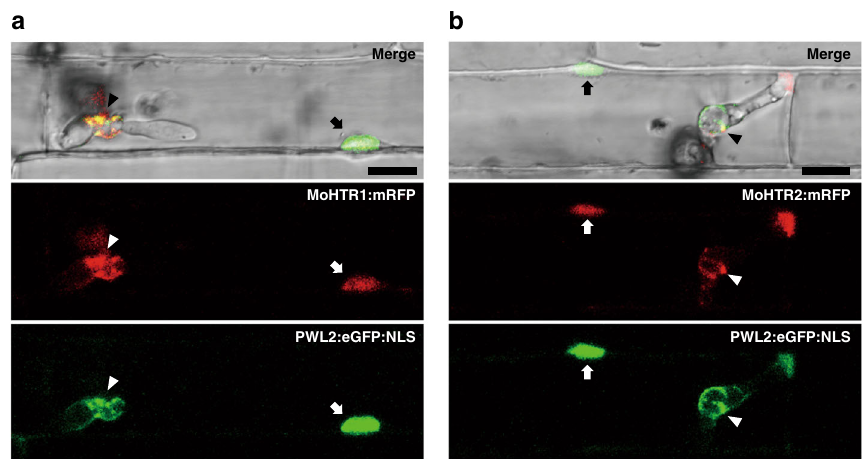
Fig. 1 Localization of MoHTR1 and MoHTR2 in rice nuclei. Differential interference contrast (DIC) and confocal images of rice sheath cells infected by M . oryzae at 30 hours post-inoculation (hpi). The fl uorescent images shown were chosen from confocal optical z-sections taken at 1- μ m intervals. Both a MoHTR1:mRFP and b MoHTR2:mRFP were co-localized with PWL2:eGFP:NLS, a maker used to label rice nuclei (arrow). Arrowheads indicate biotrophic interfacial complexes of invading M . oryzae . Scale bars = 10 μ m. Representative micrographs are shown from three independently infected rice sheaths and additional representative data are provided as a Source Data fi